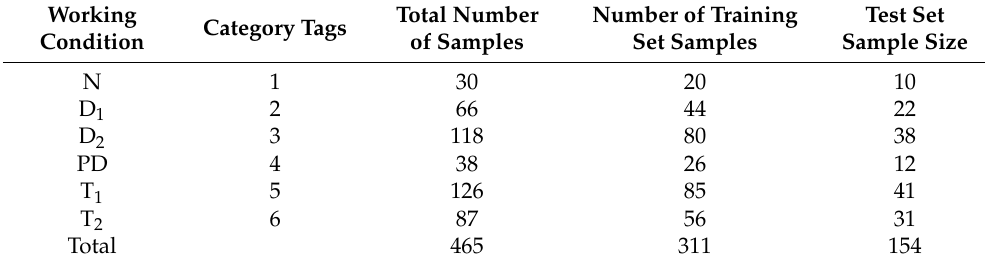
Table 5. Training and Testing Sample Distribution.